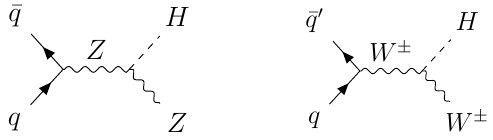
Figure 2 . Exemplary Feynman diagrams for the ZH and WH background